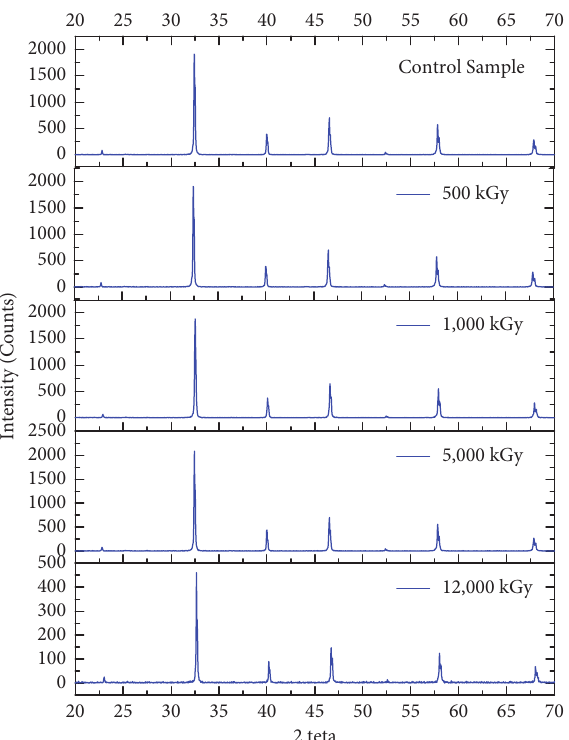
Figure 1: XRD patterns of irradiated and nonirradiated